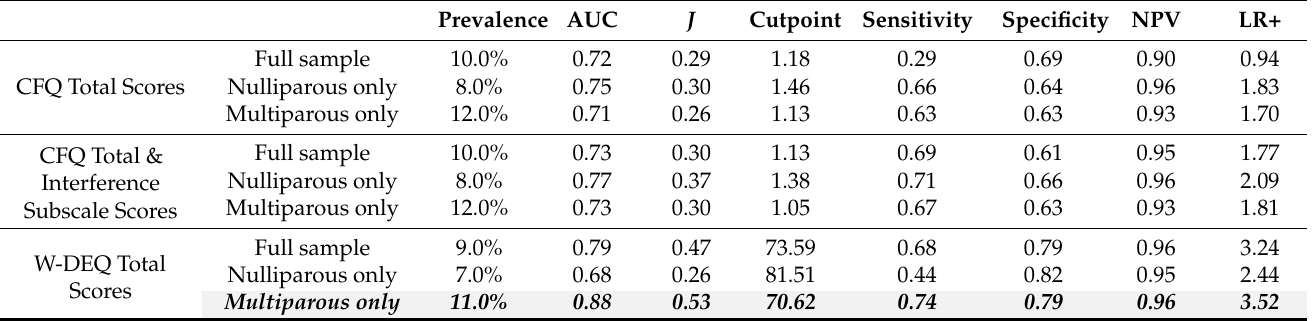
Table 4. ROC Results for the Childbrith Fear Questionnaire (CFQ) and the Wijma Delivery Expecta- tions Questionnaire (W-DEQ) across parity (subclinical and full diagnostic criteria combined).